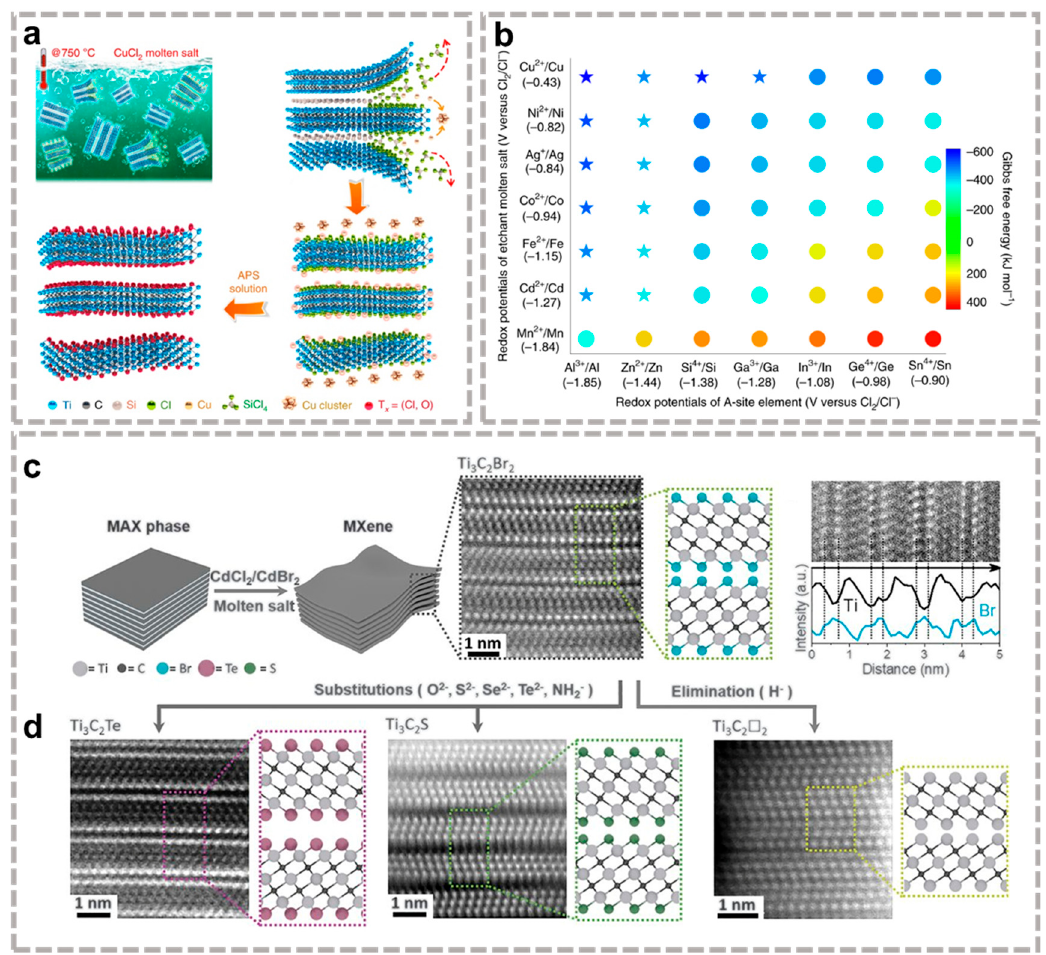
Figure 3. ( a ) Preparation process of Ti 3 C 2 T x MXene by reaction between Ti 3 SiC 2 and CuCl 2 ; ( b ) Diagram of redox potential and Gibbs free energy (700 °C) [46]. ( a , b ) Reproduced with permission from MDPI AG. ( c ) Schematics for etching MAX phases with Lewis acidic molten salts and high-angle annular dark- fi eld (HAADF) image of Ti 3 C 2 Br 2 MXene; ( d ) HAADF diagram of changing the end group by displacement and elimination reactions [47]. ( c , d ) Reproduced with permission from AAAS.